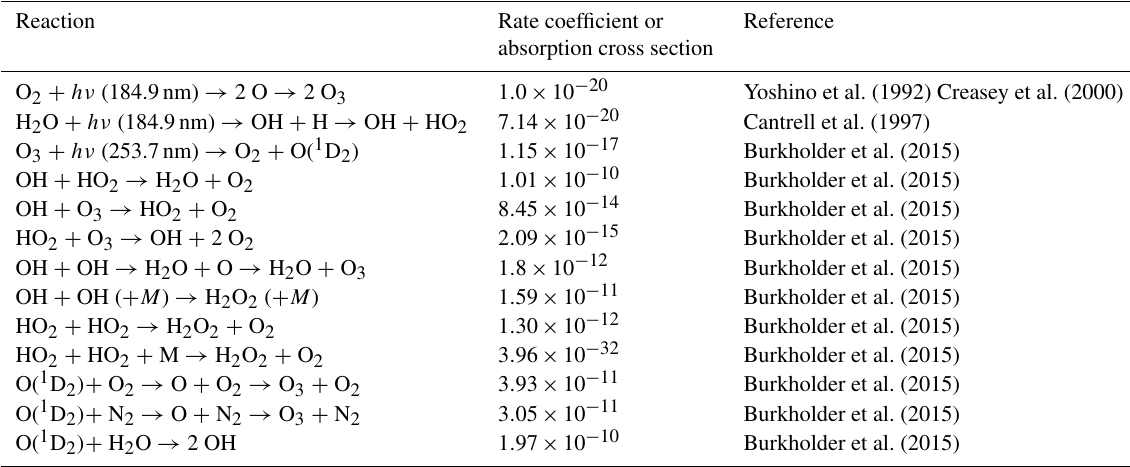
Table 3. Thermal and photochemical reactions used in modeling the effects of water vapor on the output of the ozone calibration source at 40 ◦ C and 1atm. Units are cm 2 molec − 1 for absorption cross sections, cm 3 molec − 1 s − 1 for second-order reactions and cm 6 molec − 2 s − 1 for third-order reactions.